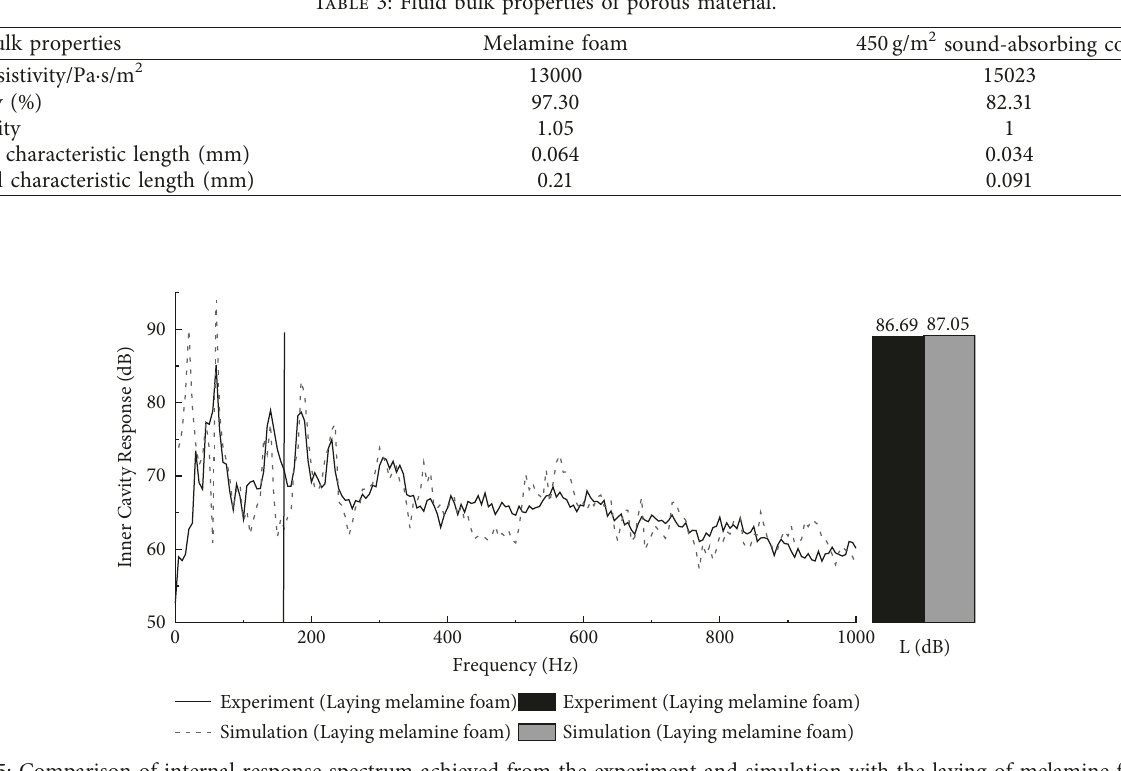
Figure 5: Comparison of internal response spectrum achieved from the experiment and simulation with the laying of melamine foam.